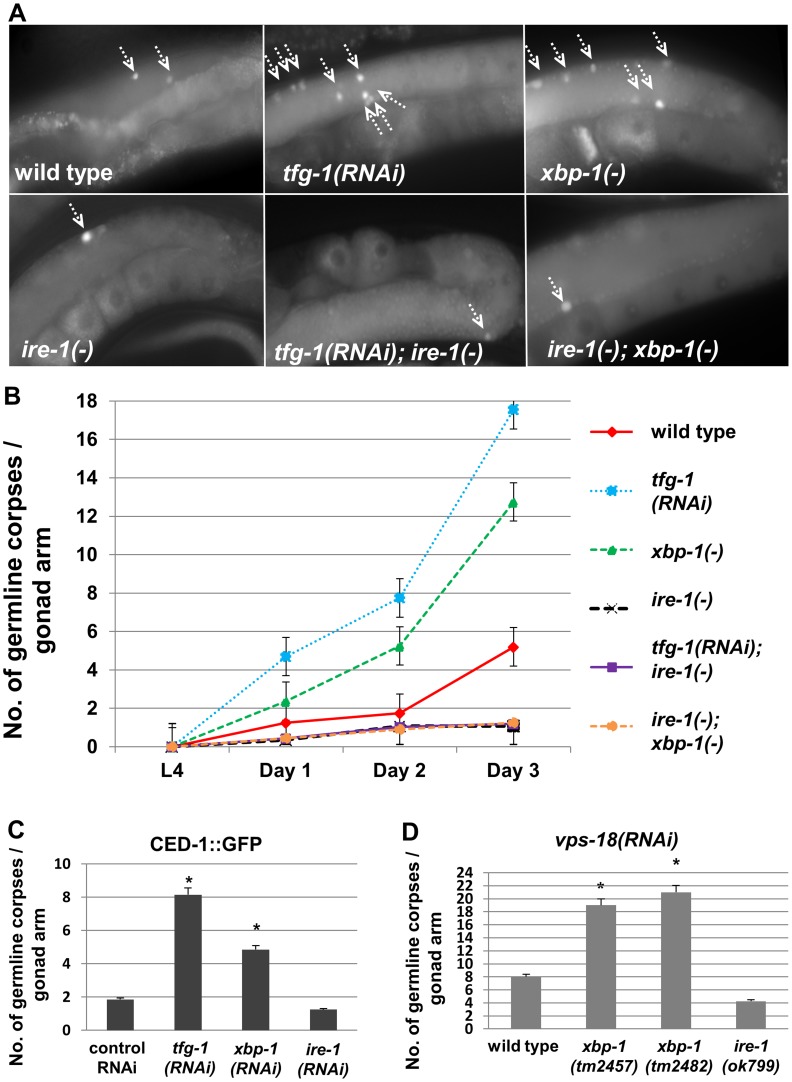
Genetically-induced ER stress increases germ cell apoptosis in an ire-1-dependent manner.(A–B) Animals of the indicated genotypes were treated with control or tfg-1 RNAi. Germ cell corpses were identified by SYTO12 staining. (A) Representative fluorescence micrographs (400-fold magnification) of SYTO12-stained germ cell corpses in day-2 adults. Top panels present gonads of wild-type, xbp-1(tm2457) or tfg-1 RNAi treated animals. Bottom panels present gonads of the corresponding genotypes in an ire-1(ok799) background. Arrows point at SYTO12-stained germ cell corpses. (B) Time course analysis of cell corpses in the adult gonads of the indicated genotypes. SYTO12-labeled cell corpses were scored at L4, day 1, day 2 and day 3 of adulthood. Each point represents the mean number of cell corpses scored in 30 gonads. Error bars indicate SEM. (C) Animals expressing CED-1::GFP were treated with control, tfg-1, xbp-1 or ire-1 RNAi and analyzed. Bar graph shows average number of apoptotic corpses per gonad arm in the indicated genotypes identified by their engulfment by CED-1::GFP labeled gonadal sheath cells. Asterisk indicates a significant increase in germline apoptosis compared to control RNAi-treated animals (Student's t-test values of P<0.001). (D) Bar graph shows average number of SYTO12-labeled apoptotic corpses per gonad arm in day-2 vps-18 RNAi-treated animals (n = 40 gonads per genotype). Asterisk indicates a significant increase in germline apoptosis compared to wild-type animals treated with vps-18 RNAi) Student's t-test values of P<0.001).